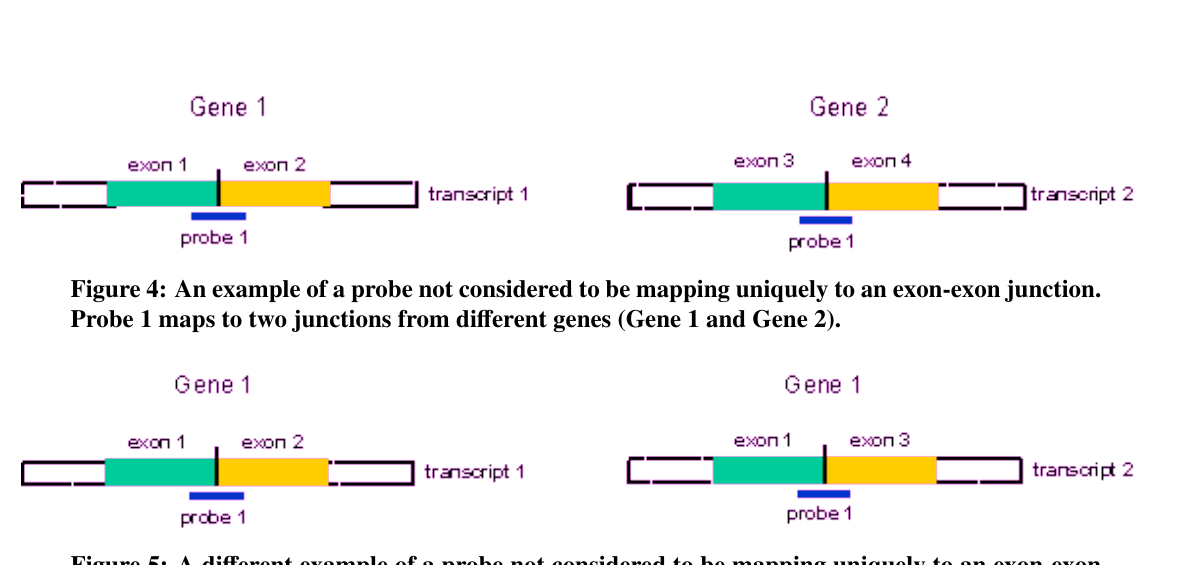
Figure 5: A di ff erent example of a probe not considered to be mapping uniquely to an exon-exon junction. Probe 1 maps to two exon-exon junctions which are from the same gene but contain di ff erent exons (i.e. probe 1 maps to di ff erent genomic regions) and therefore the mapping is not